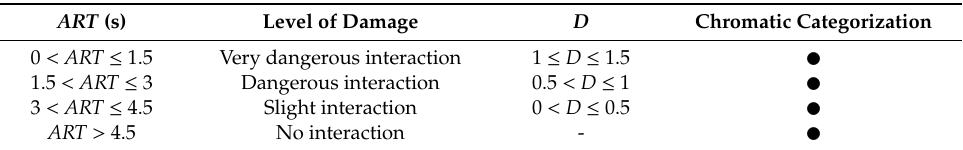
Table 1. Danger classification. ART : available reaction